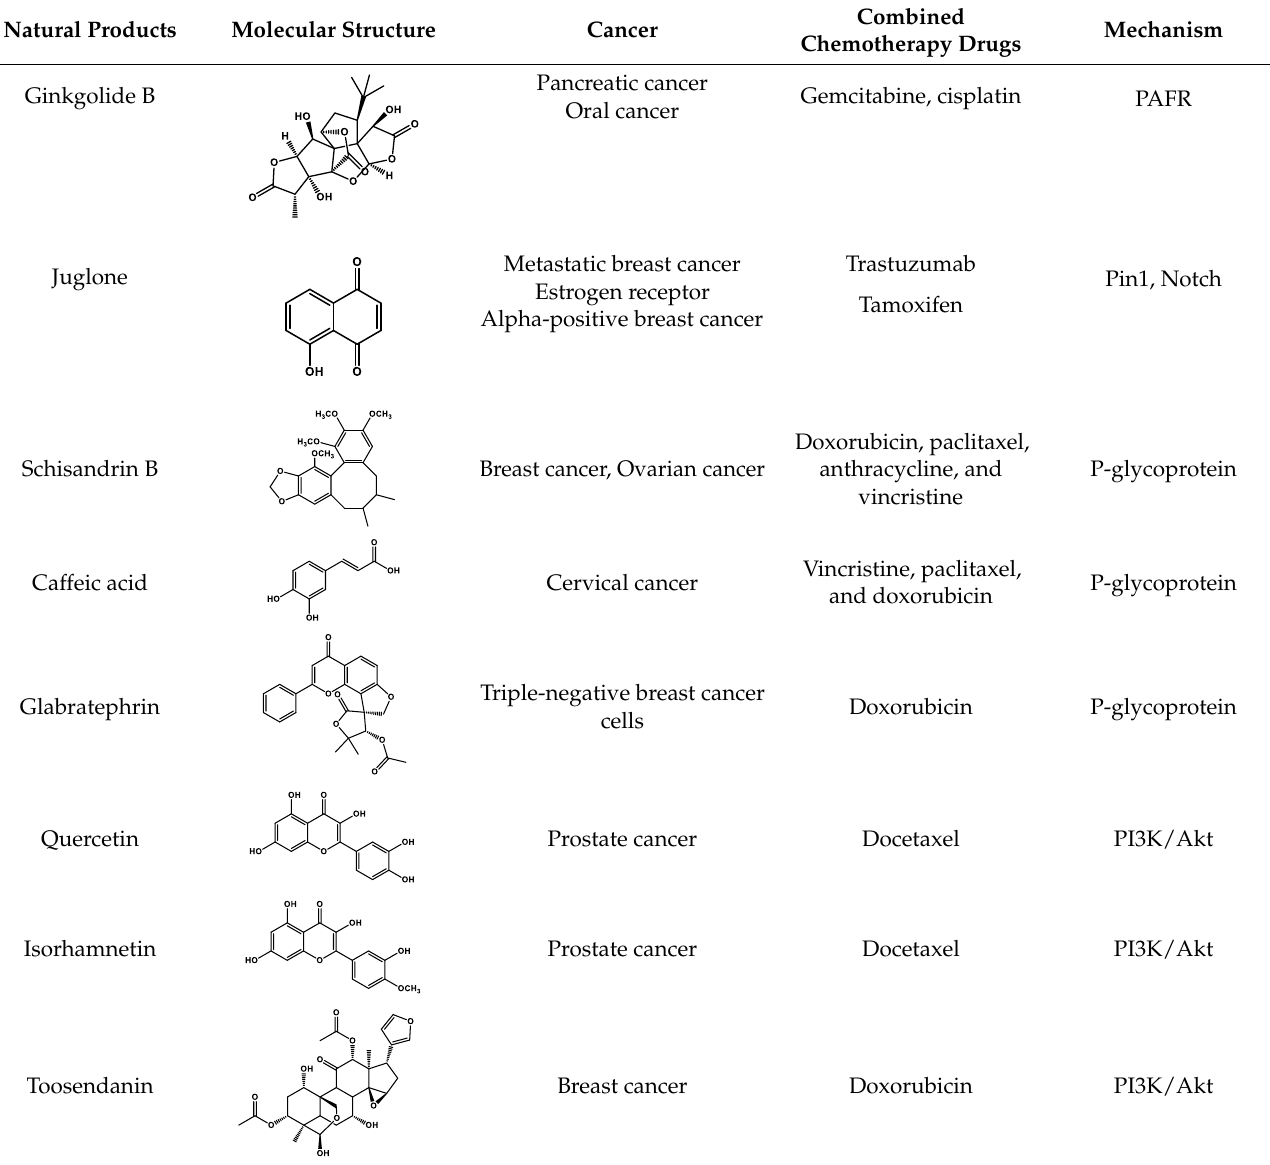
Table 2. Natural compounds that reduce tumor drug resistance and their mechanisms.